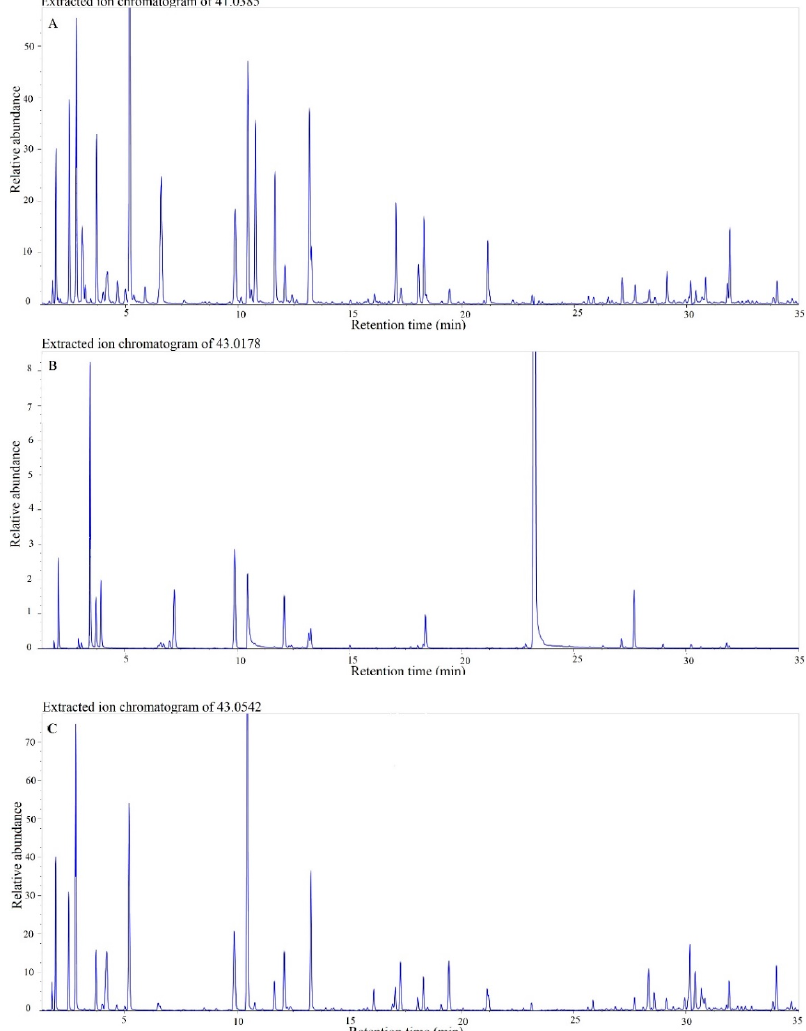
Figure 1. Extracted Ion Chromatogram (XIC) of a 1 nL/L sample. ( A ) XIC of m/z 41.0385; ( B ) XIC of m/z 43.0178; ( C ) XIC of m/z 43.0542.